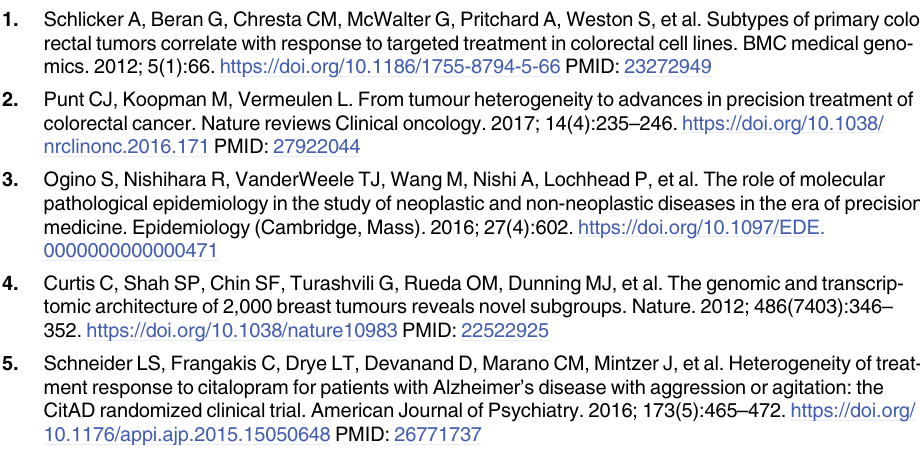
S1 Table. Autism dataset. This is a tab-delimited file with relative abundances summarized at the genus level. S1 File. R code. Functions that generate the compositional clusters in simulation experiments 1, 2, and 3, as described in detail in the Results